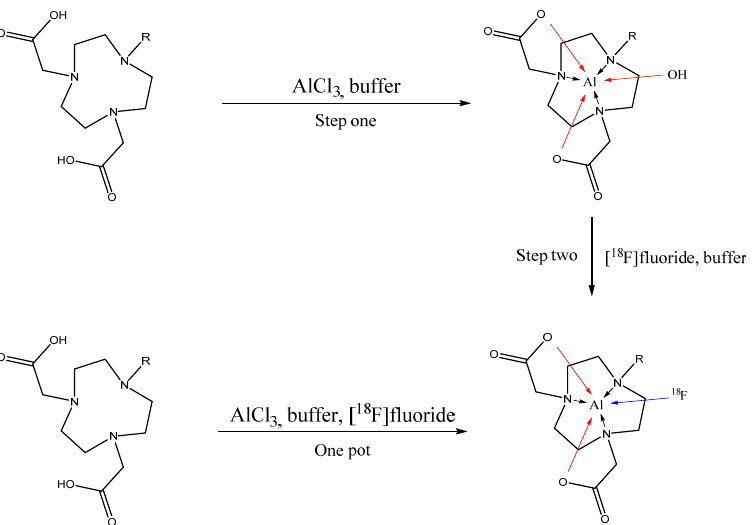
Figure 1. Two possible ways of forming [ 18 F][AlF(NODA)] complexes. Outlined below is the